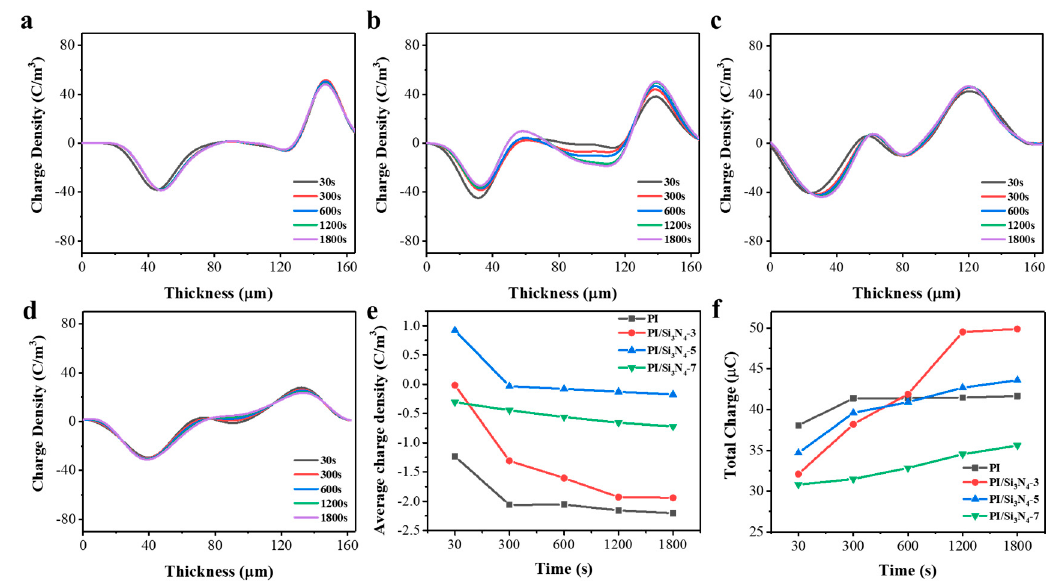
Figure 6. Space charge distribution in the pure PI ( a ), the 3 wt.% PI / Si 3 N 4 ( b ), the 5 wt.% PI / Si 3 N 4 ( c ) and the 7 wt.% PI / Si 3 N 4 ( d ) nanocomposite films, and the curves of the average charge density of these ( e ) and the total charge quantity of these ( f ).